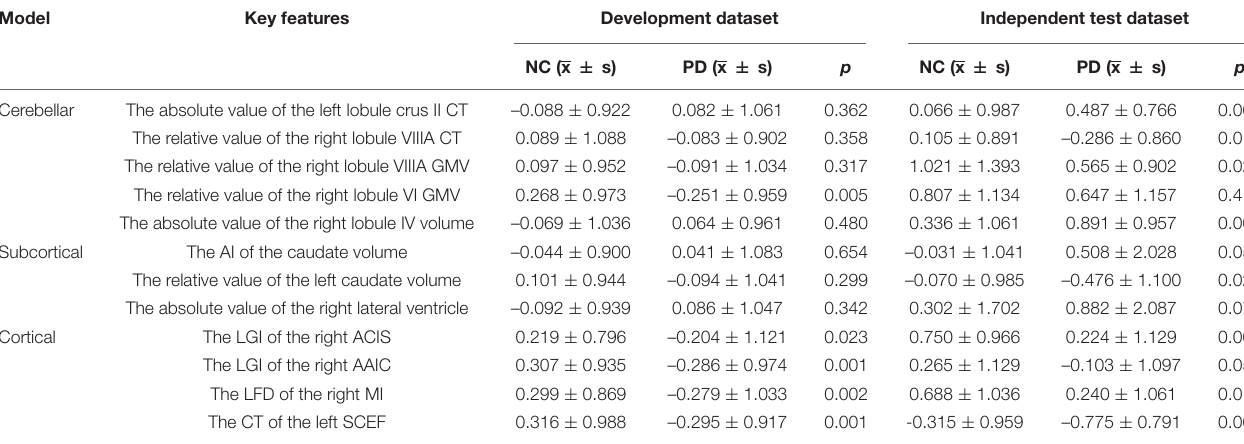
TABLE 2 | Comparison of the selected features in the development and independent test datasets. Model